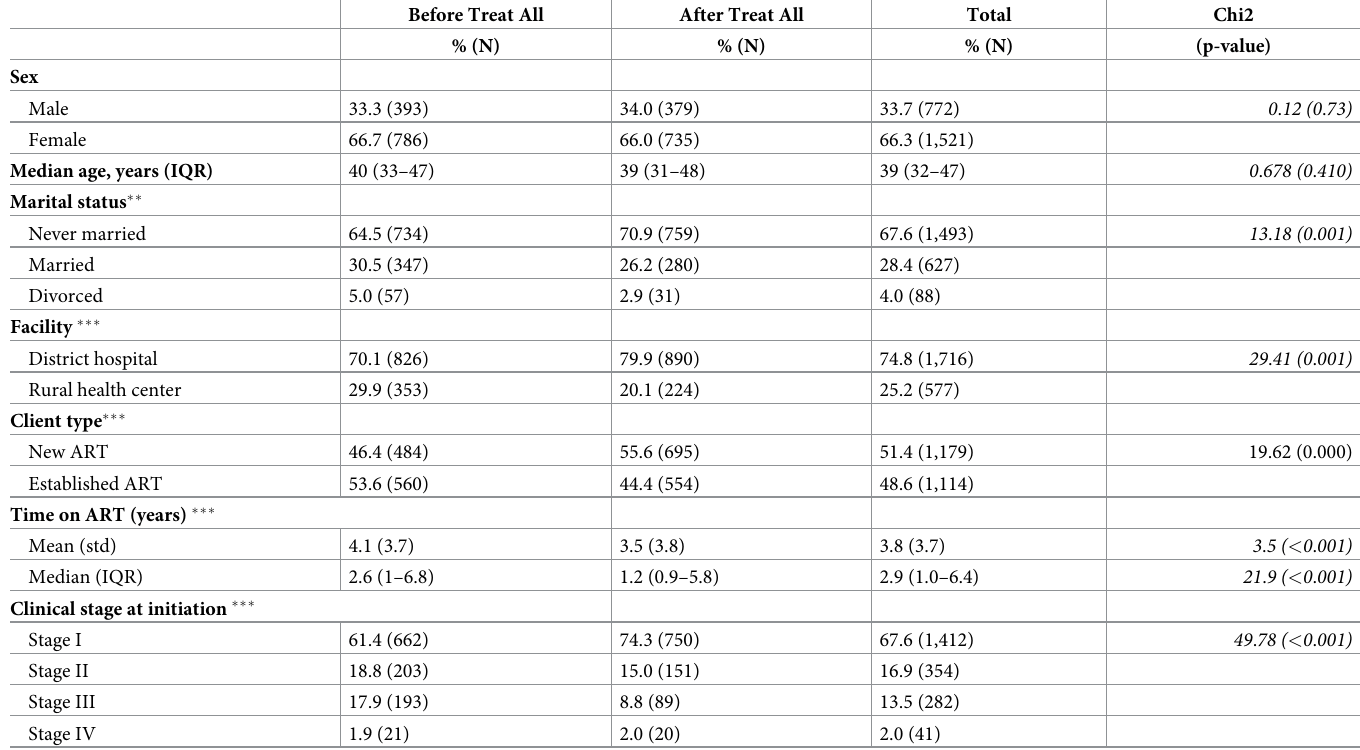
Table 2. Sociodemographic characteristics of the pre and post Treat All samples. Before Treat All After Treat